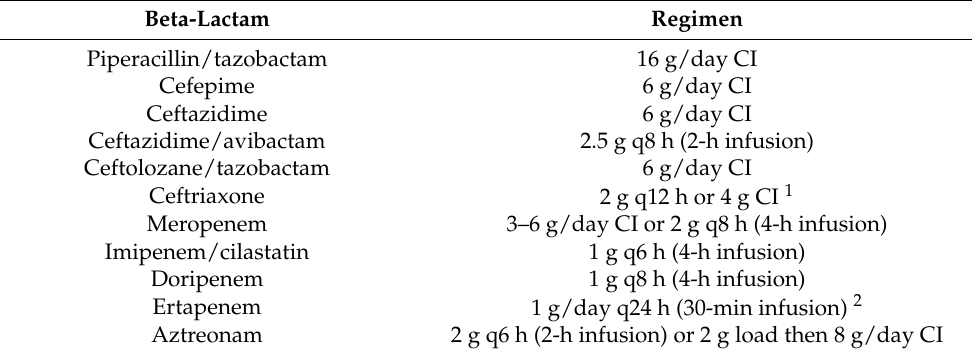
Table 2. Suggested beta-lactams’ initial dosing for resistant Gram-negative infections in patients with normal renal and hepatic